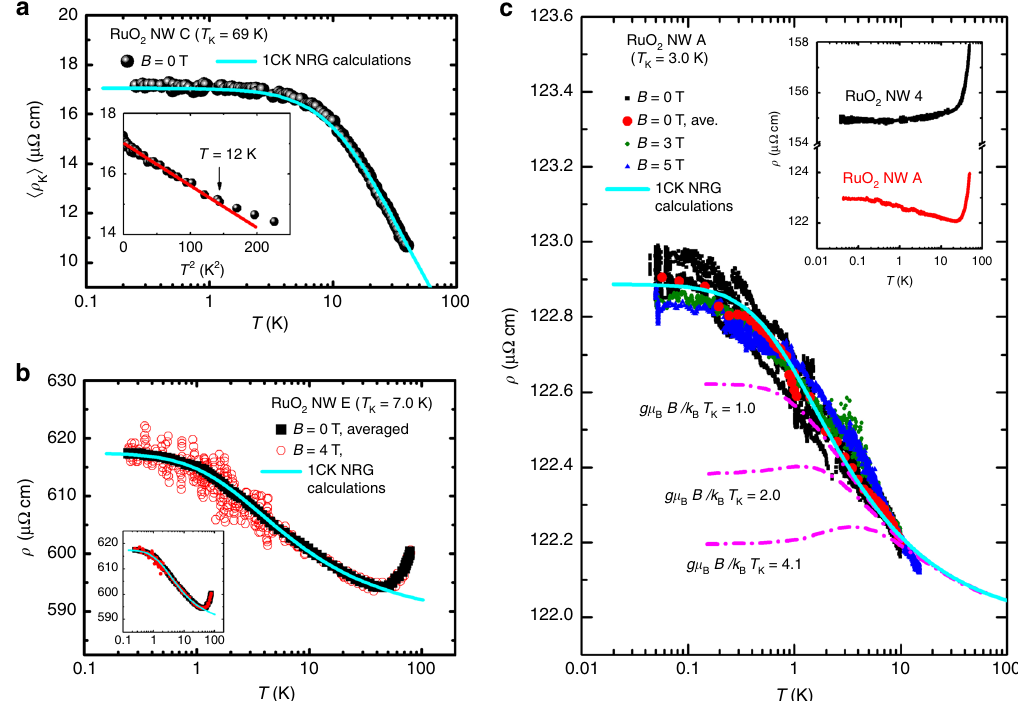
Fig. 3 Orbital 1CK resistivity of RuO 2 NWs. a Time-averaged Kondo resistivity 〈 ρ K 〉 versus log T for NW C. The straight line in the inset, which shows a low- T zoom-in, is a guide to the eye. b ρ versus log T in B = 0 and 4 T for NW E. For clarity, the B = 0 data are time-averaged, while the 4-T data are non- averaged to demonstrate the temporal resistivity fl uctuations at low T . The inset shows the time-averaged B = 4 T data (red symbols), which closely overlap the B = 0 data. c ρ versus log T for NW A in B = 0, 3, and 5 T. Occasional resistivity jumps, or random telegraph noise, are observed. The dash- dotted curves depict the magnetoresistance predicted by the spin- 1 Kondo impurity model (see text). Note that the experimental data are independent of B . 2 Inset: Low- T ρ ( T ) curves of NW A and a reference, oxygenated NW 4 ( d = 150 nm, ρ (300 K) = 336 μΩ cm). In a – c , the solid curve shows the B = 0 numerical renormalization group result for 1CK effect 59